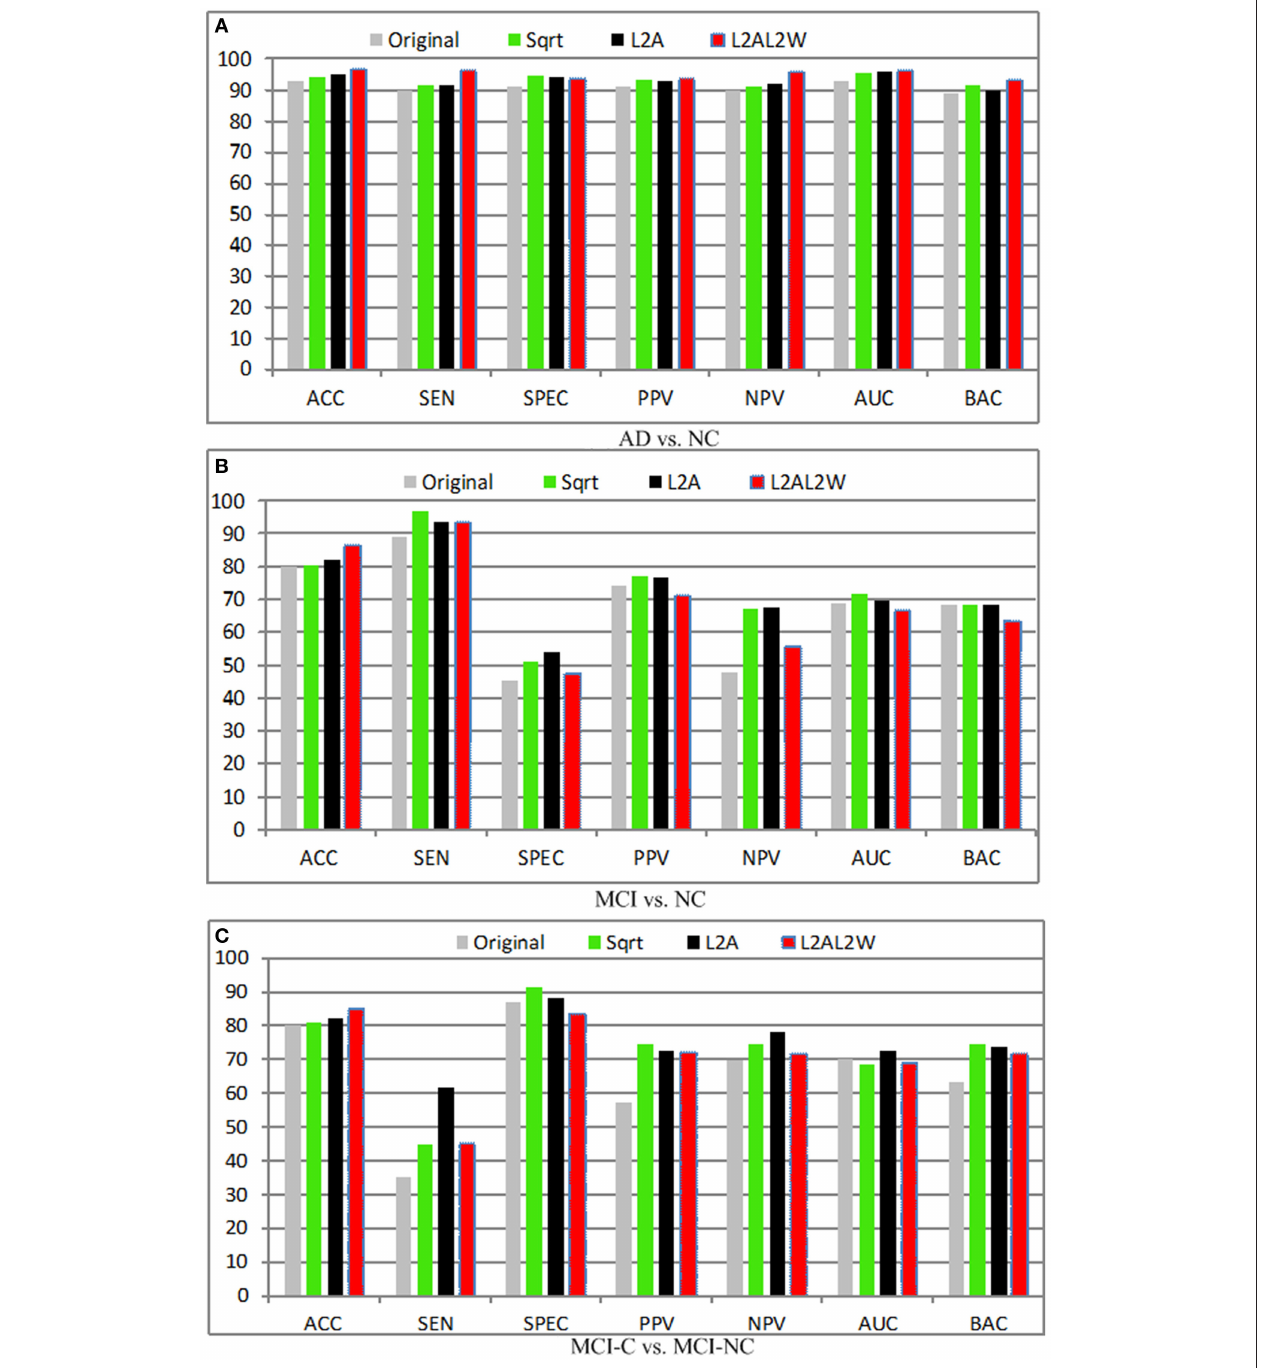
FIGURE 9 | Diagnosis results with different normalization methods. (A) AD vs. NC; (B) MCI vs. NC; (C) MCI-C vs.